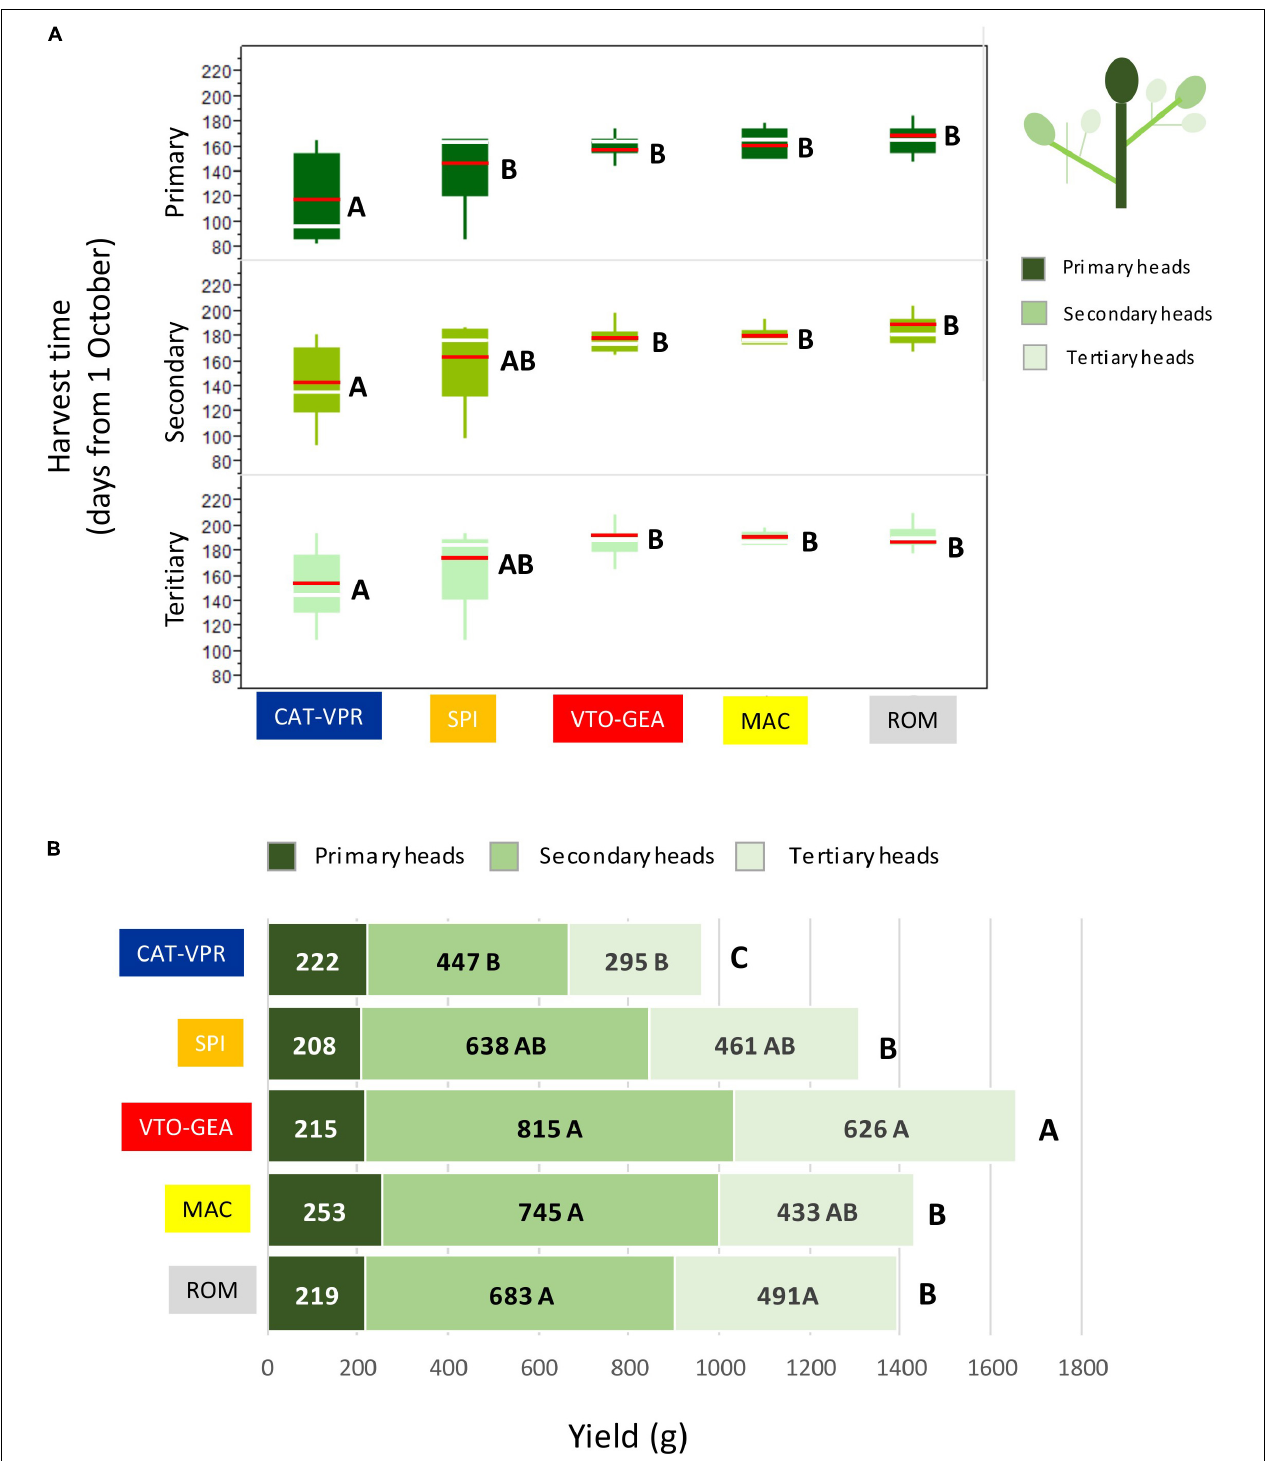
FIGURE 4 | Differences between the SSR groups for the average harvest time (A) and yields of primary, secondary, and tertiary heads (B) . Group means are compared referring to the same head type (i.e., primary, secondary, and tertiary) and means with different letters are significantly different ( p < 0.05; Tukey-Kramer HD test). In panel (A) green boxes = interquartile range; red bar = mean; white bar = median.